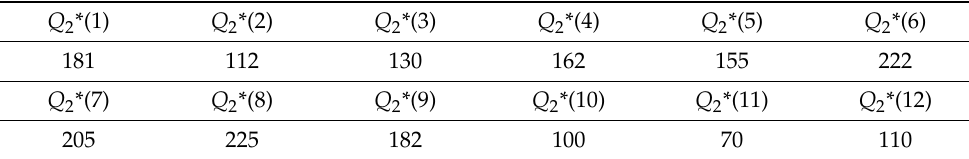
Table 13. Optimal delivery plan for warehouse 2 ( τ * = 1).